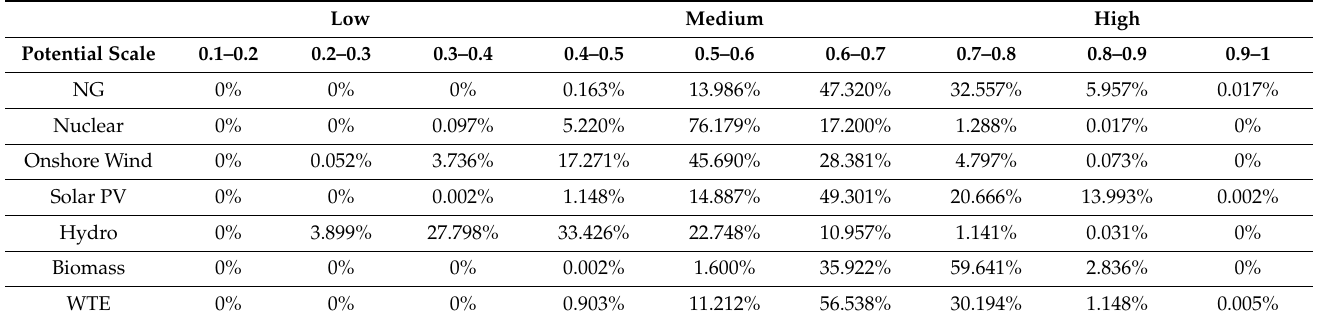
Table 5. Percentage of areas in each potential scale out of the suitable area for alternative power